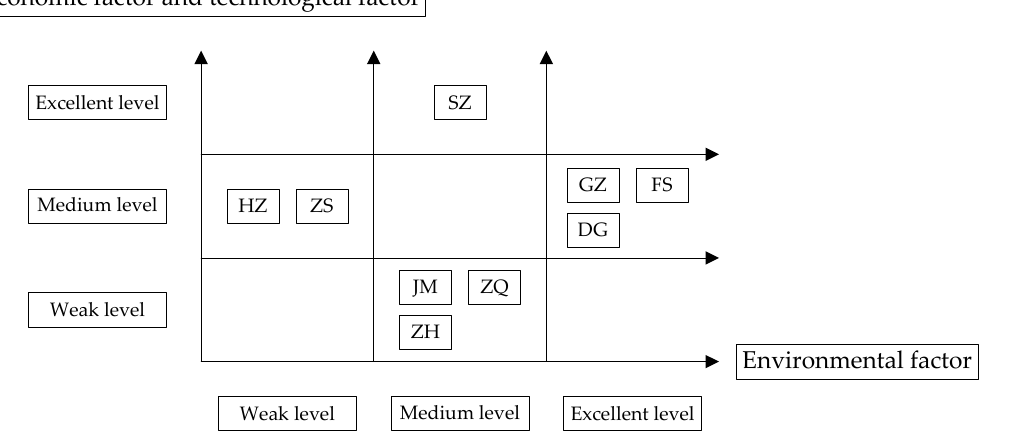
Figure 2. Typical situations of the manufacturing industries in regional cities.